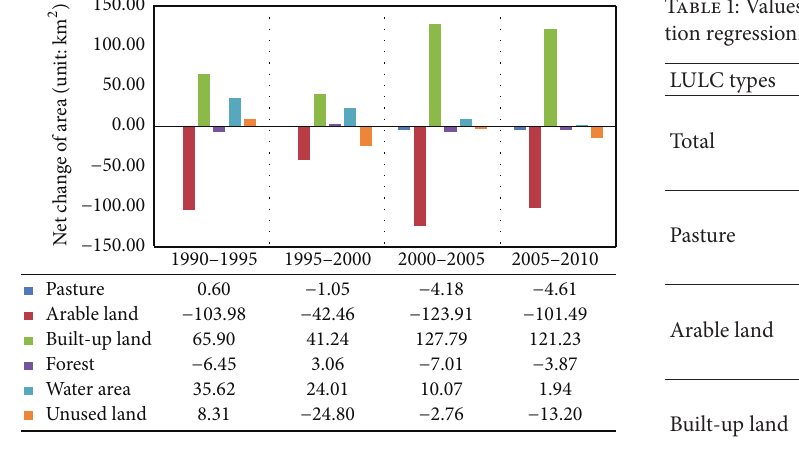
Figure 4: Net change of each LULC type in Wuhan city (unit: km 2 ).